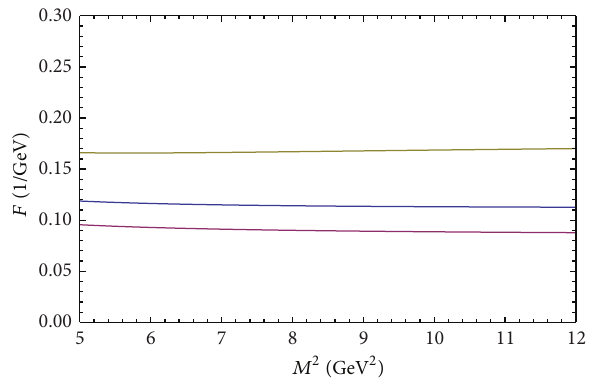
Figure 3: The dependence of the 𝐹(𝑞 2 = −10) on 𝑀 󸀠2 for three different values of 𝑠 0 = 13.8, 14.54, 16.11 , 𝑠 󸀠 0 = 11.56, 12.25, 13.69 , and 𝑀 2 = 8 for the 𝜒 𝑐0 → 𝐽/𝜓𝛾 decays. The green, blue, and purple lines are for minimum, central, and maximum values of 𝑠 0 and 𝑠 󸀠 0 .